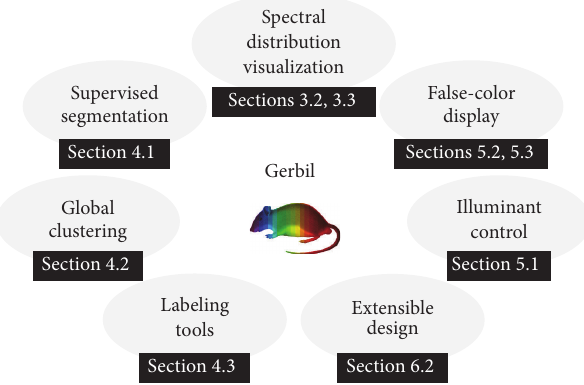
Figure 2: Overview of the Gerbil feature set and corresponding article